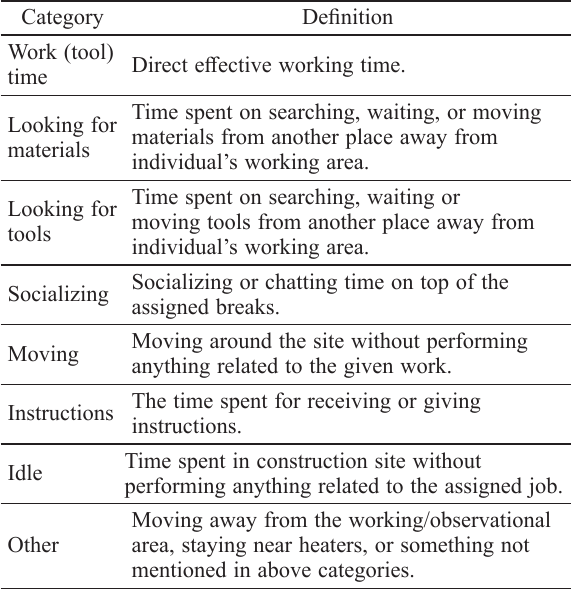
Table 3. Working patterns of construction workers and observational categories Category